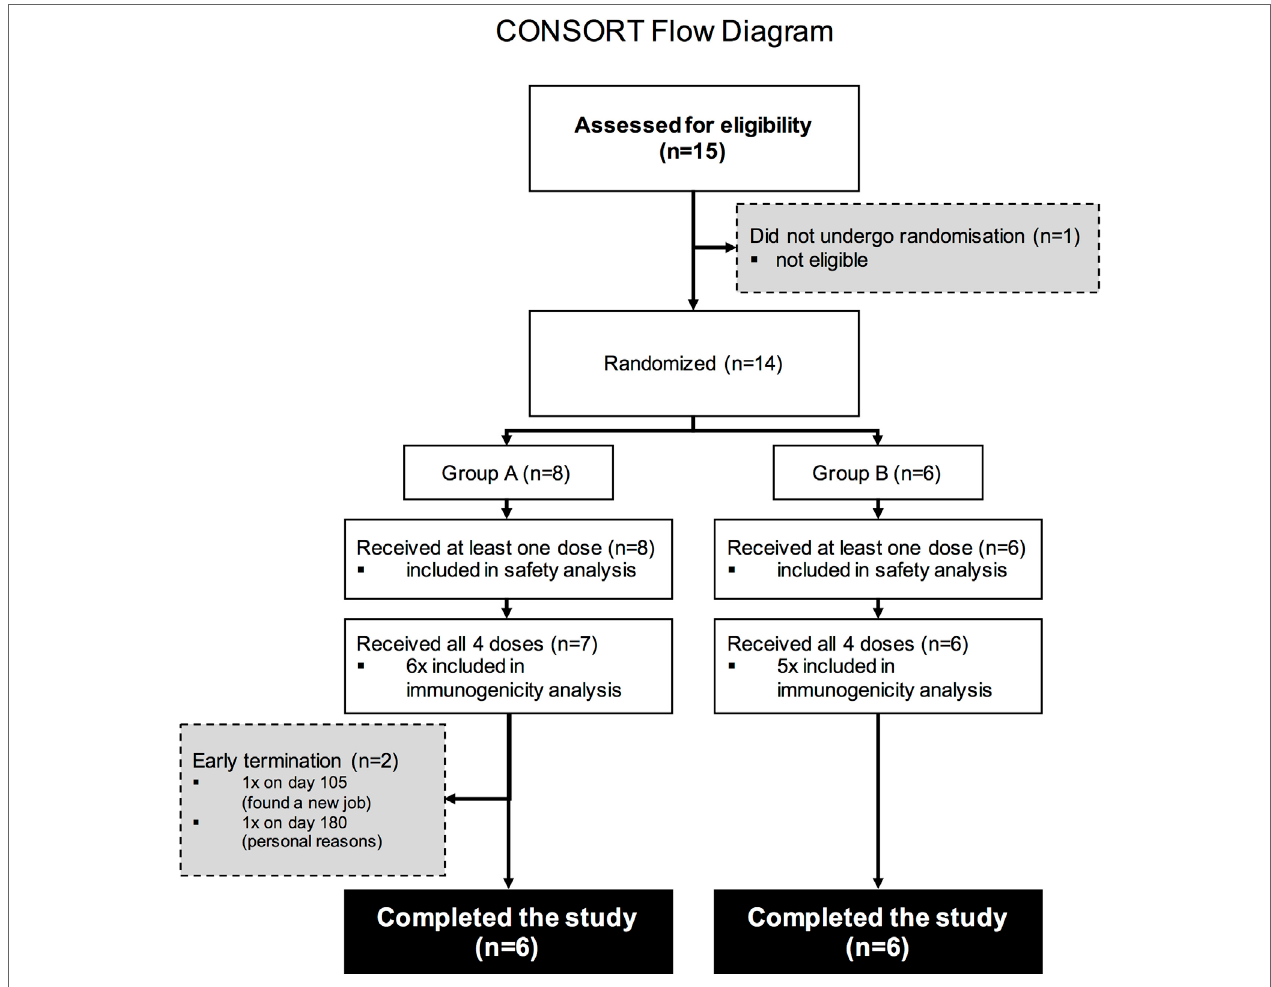
FiGUre 1 | COnSOrT Flow diagram . Numbers of participants recruited into the trial. Fifteen individuals were screened for the study, 14 were enrolled into the study (8 were enrolled into Group A, 6 into Group B), and 13 volunteers received all four intramuscular